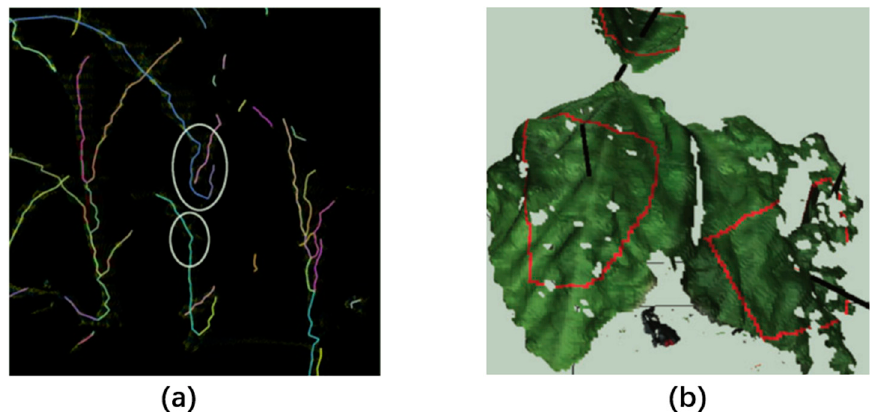
Figure 9. ( a ) Skeleton segments that contain both stems and leaves [30]; ( b ) 3D reconstruction of a soybean leaf consisting of three leaflets. Black lines: normal vectors to fitted plane; red contour: projected region of interest (ROI) used for plane fitting [114].